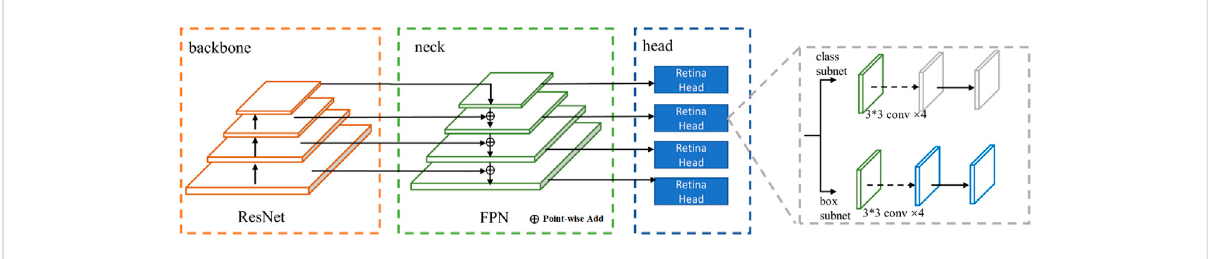
FIGURE 1 The structure of RetinaNet.